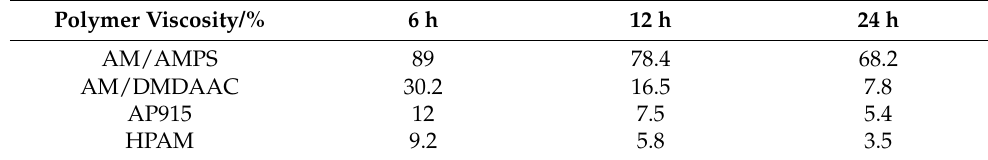
Table 2. Viscosity Retention of Various Polymers.